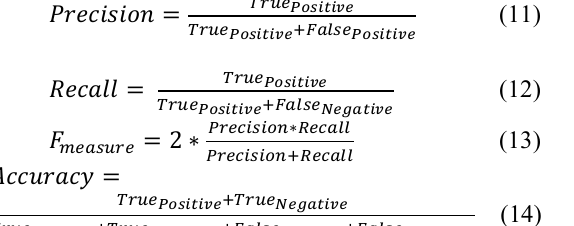
Table 4. Precision, Recall, and F-measure obtained using k-means, k-means with PSO and k-means with